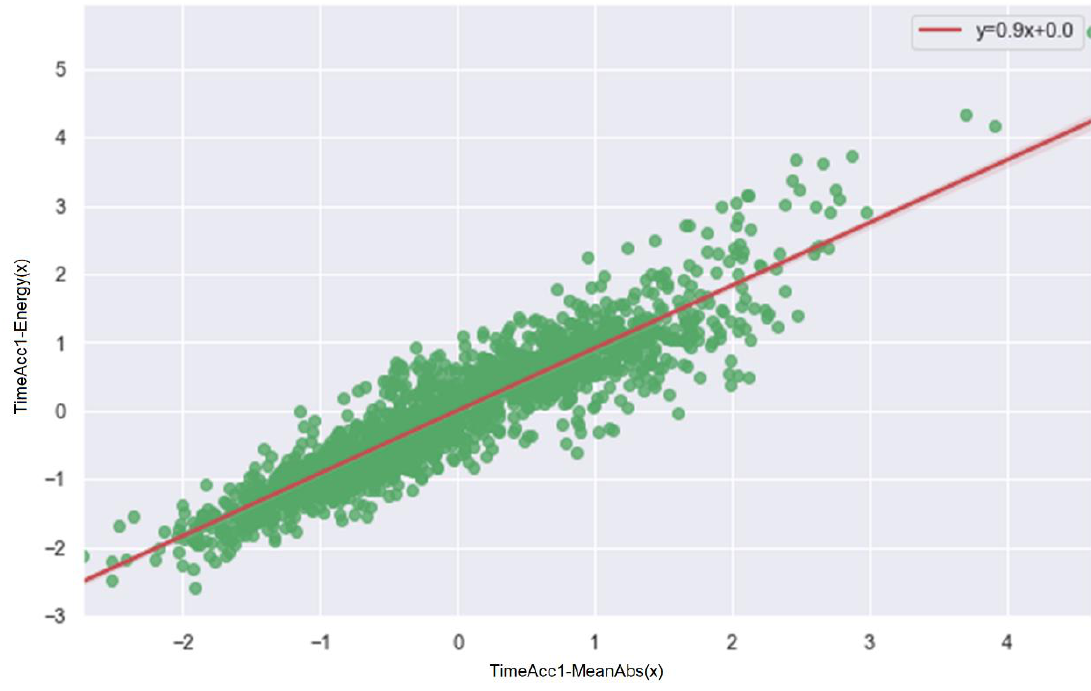
Figure 6. Linear regression graph. Table 2. Summary of